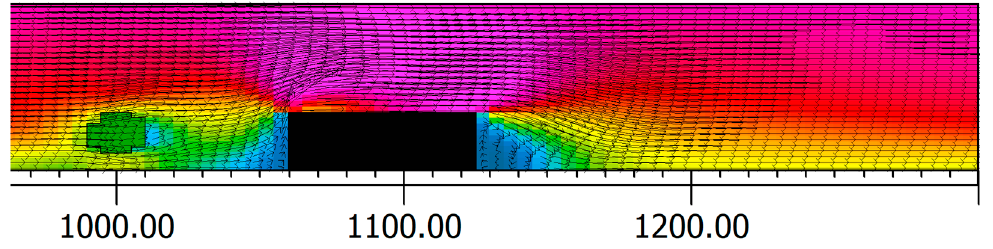
Figure 9. Two-dimensional vertical cut visualizing the wind flow in the inhomogeneous model area.